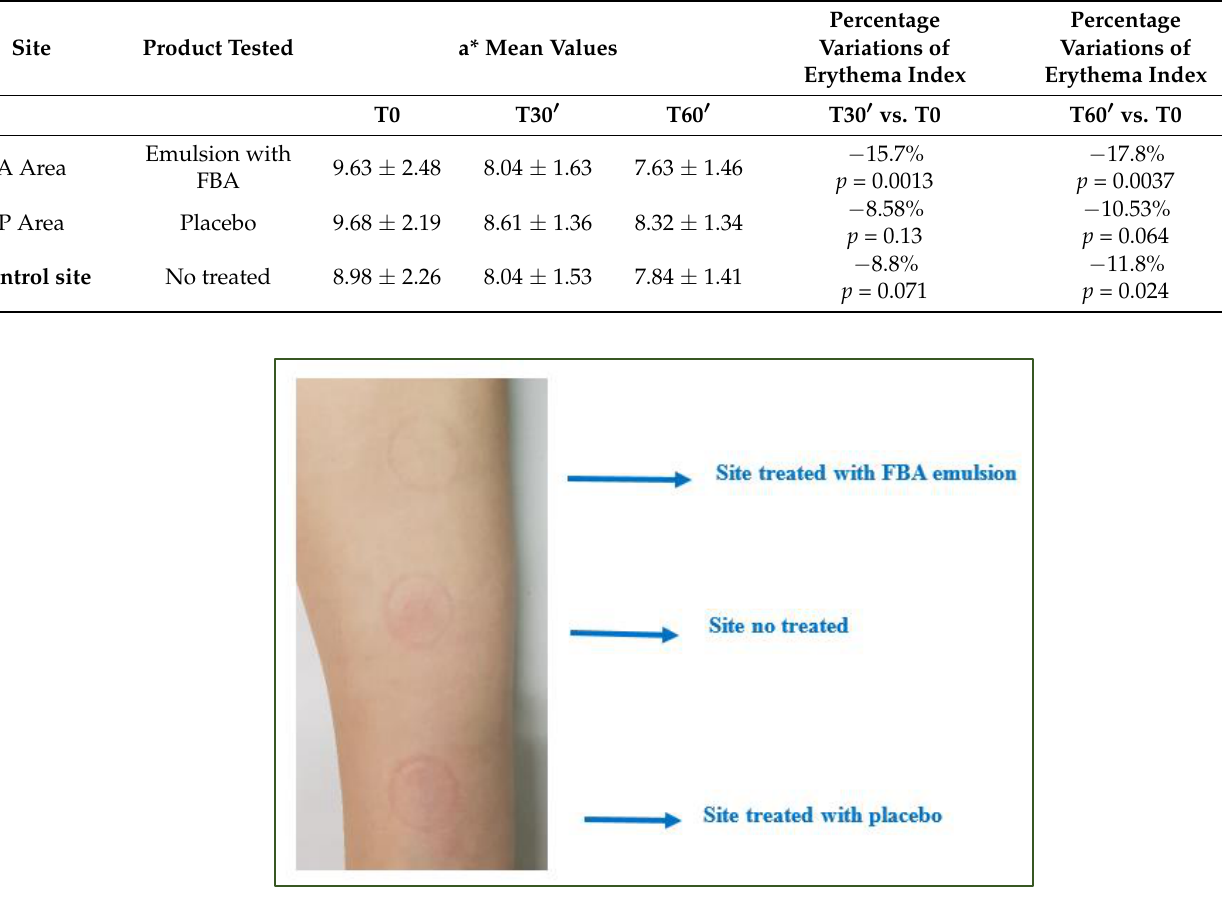
Figure 3. Image of the three test sites identified on the volunteer ’ s forearm at T1h.